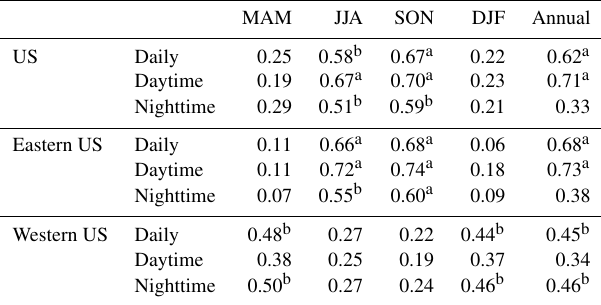
Table 4. Correlations ( R ) between detrended time series of AMONI index and detrended daily mean ozone, daytime mean ozone, and nighttime mean ozone in different seasons and